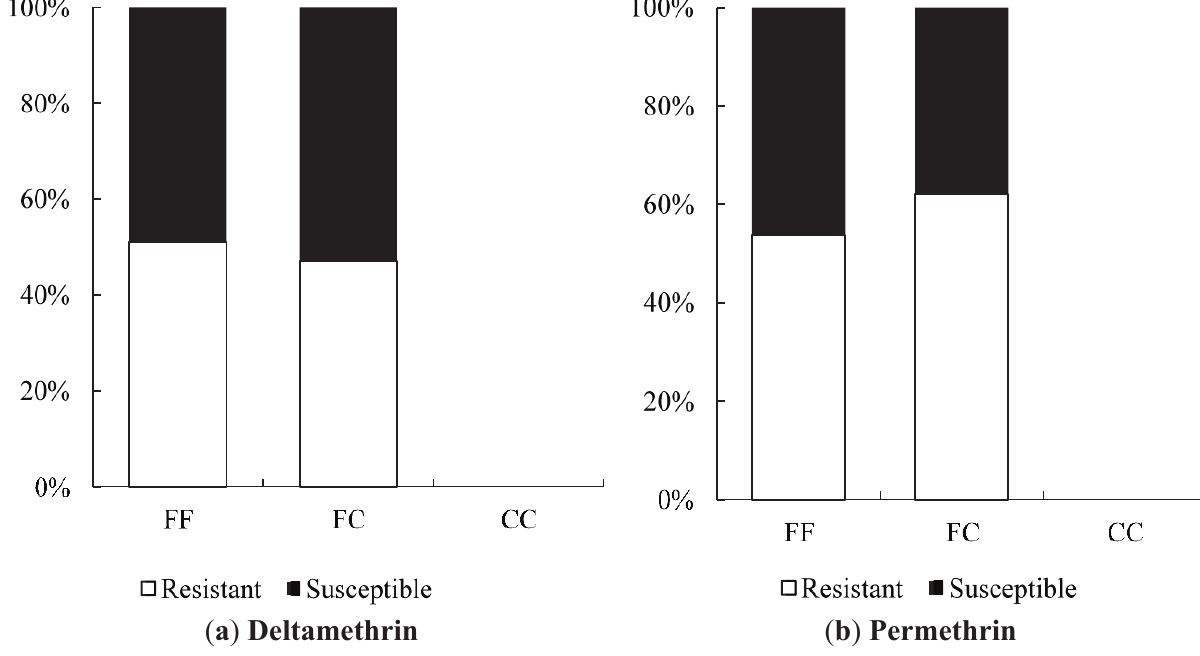
Figure 3. Association between Vssc F1565C mutation and resistance for Aedes aegypti from Yogyakarta (Site 6, Site 8 and w MelYog line). ( a ) Distribution of F1565C genotypes between deltamethrin-resistant and deltamethrin-susceptible mosquitoes. Only one individual of CC genotype was observed therefore this genotype is not presented ( b ) Distribution of F1565C genotypes between permethrin-resistant and permethrin-susceptible mosquitoes. Genotype CC was not observed in the permethrin